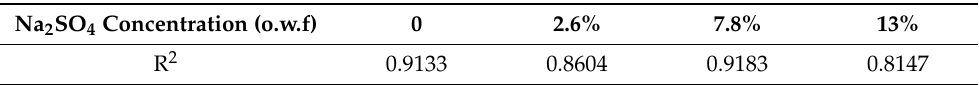
Figure 4. Pseudo-first-order kinetic fitting curve of reactive dyeing with different concentrations of Figure 4. Pseudo- fi rst-order kinetic fi tt ing curve of reactive dyeing with di ff erent concentrations of sodium sulfate (( a ) 0%, ( b ) 2.6%, ( c ) 7.8%, ( d ) 13%) in siloxane non-aqueous dyeing system. Table 2. R 2 of pseudo-first-order kinetic model of reactive dyeing with different sodium sulfate Table 2. R 2 of pseudo- fi rst-order kinetic model of reactive dyeing with di ff erent sodium sulfate con- centration.